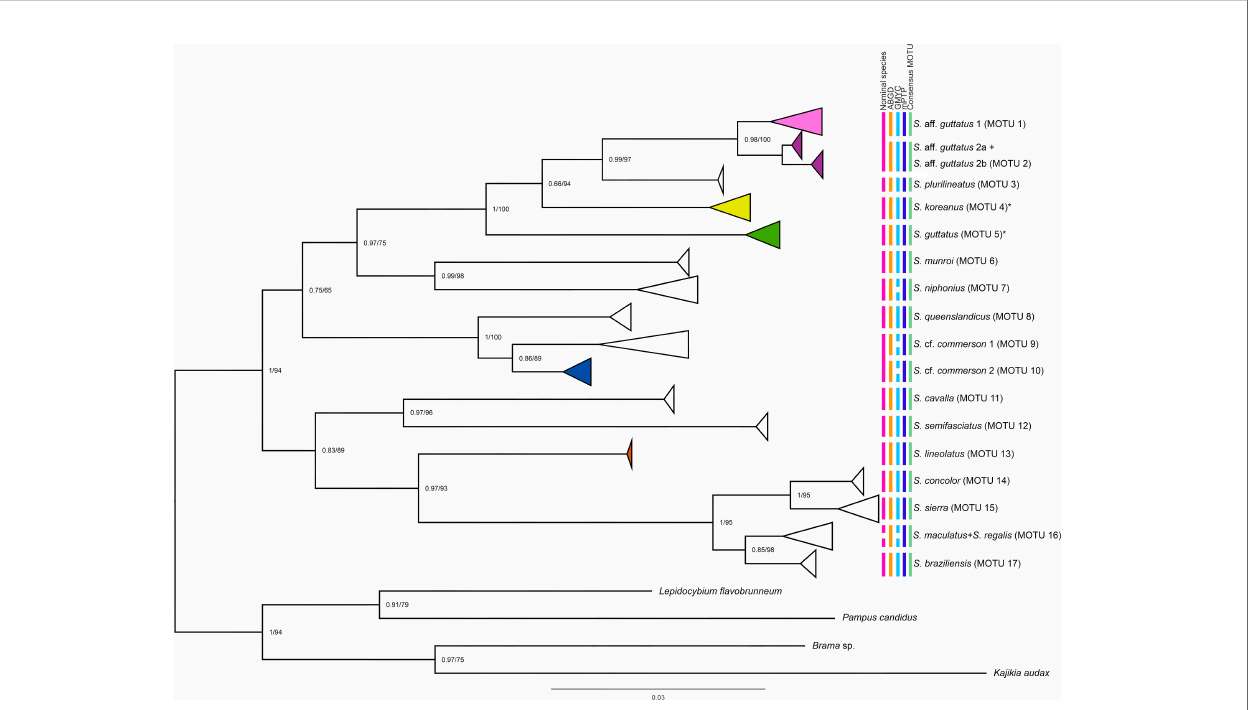
FIGURE 2 | Phylogenetic tree depicting the relationships between Scomberomorus spp. based on Bayesian inference (BI) superimposed on maximum likelihood (ML) analysis of partial COI sequences ( Supplementary Table 1 ). The node numbers specify the posterior probability and bootstrap support values, respectively. Leaves are collapsed to indicate the well-supported clades and species from India are highlighted in colors. The nominal species, results of delineation methods, and consensus MOTUs are indicated by different colors to the right of the